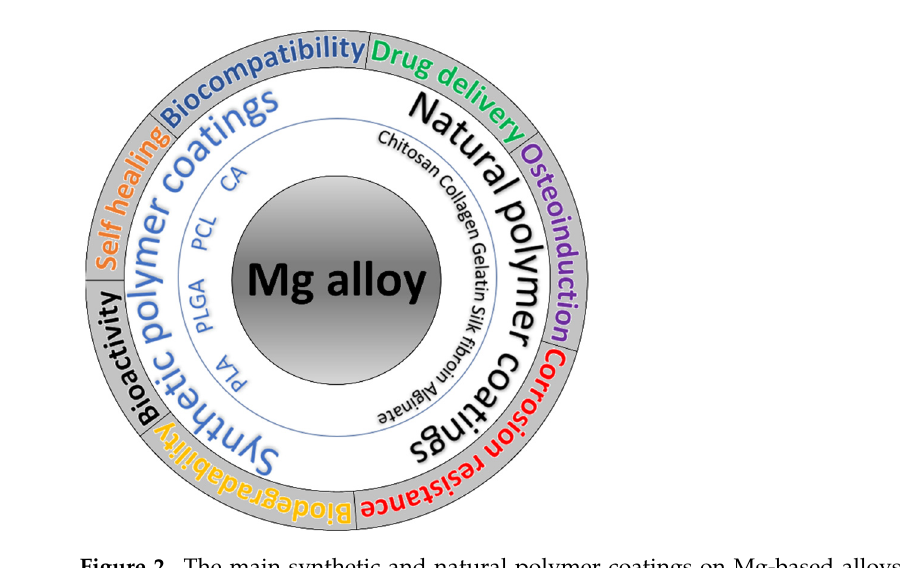
Figure 2. The main synthetic and natural polymer coatings on Mg-based alloys and their main functionalities in the medical domain. Table 2. Different types of composite coatings on Mg-based